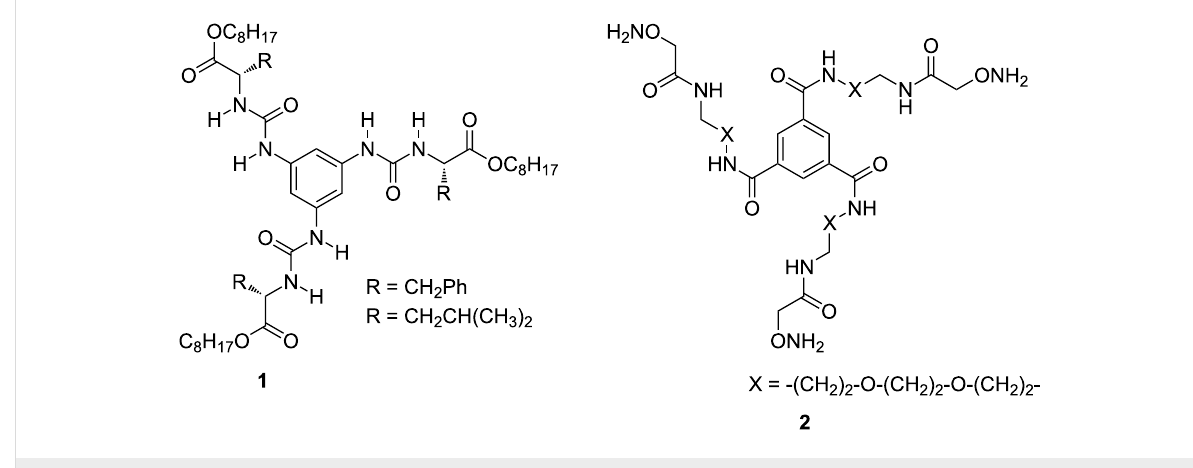
Figure 1: Exemplar C 3 -symmetric peptide scaffolds reported in the literature.